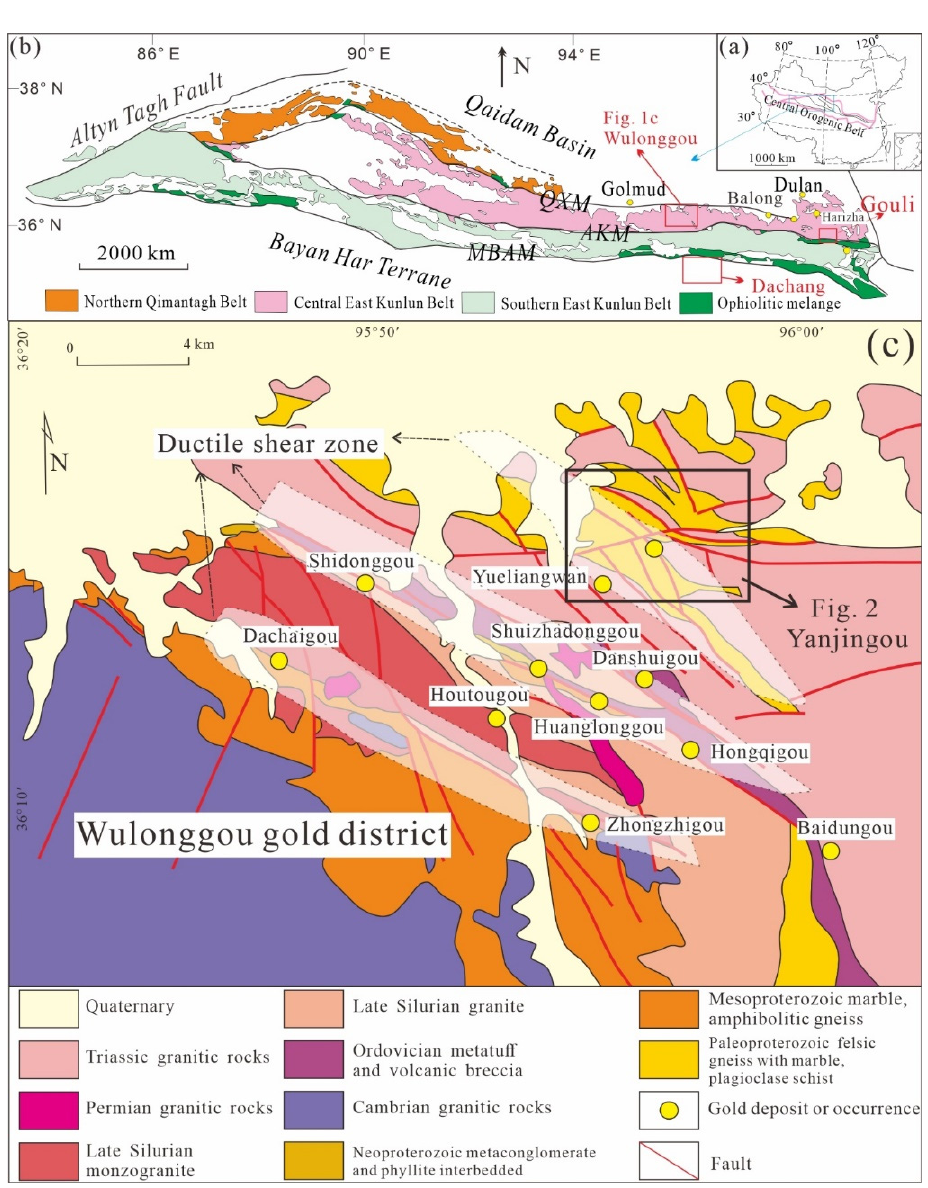
Figure 1. ( a ) Tectonic map of the study area, ( b ) Geological map of the East Kunlun Orogen, and ( c ) Geological map of the Wulonggou Au district (modified after [9]).